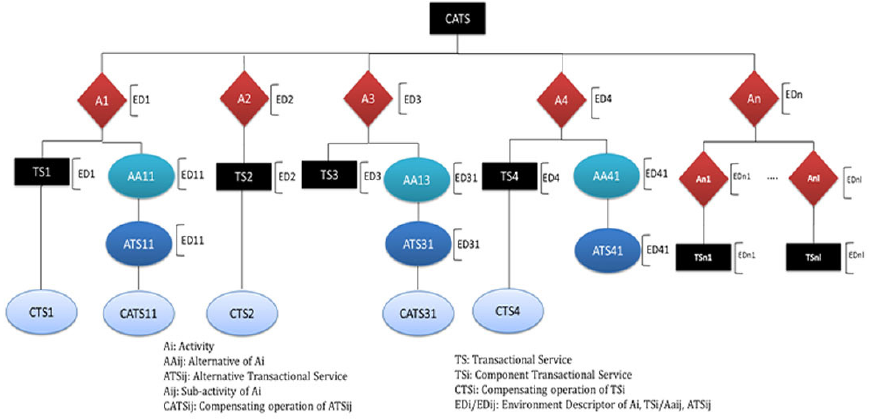
Fig. 1. Succinct illustration of CATS service